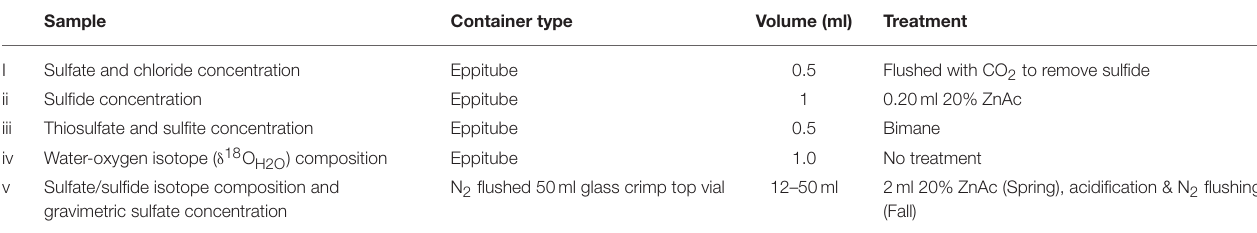
TABLE 1 | Sampling